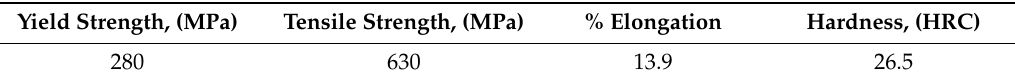
Table 2. The mechanical properties of the NiTi